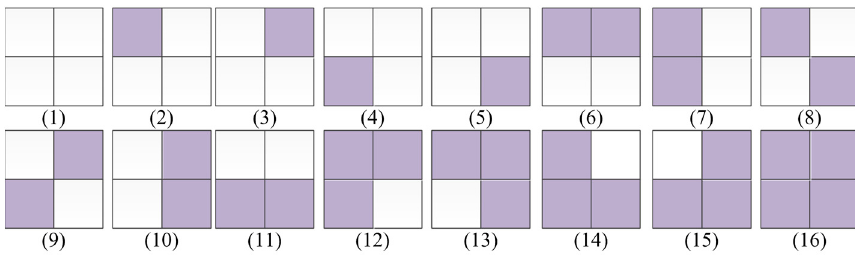
Figure 1. The proposed texture elements.